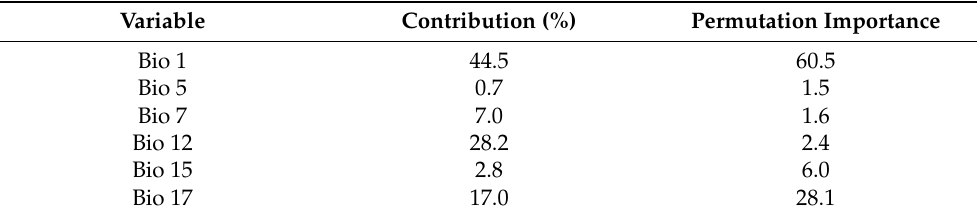
Table 1. Contribution (%) and permutation importance of environmental variables in predicting the occurrence of S. geminata in the MaxEnt